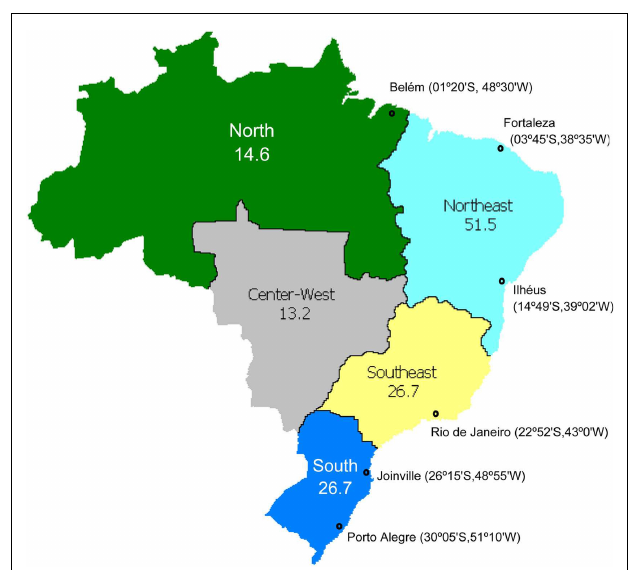
FIGURE 1 | Map of Brazil, showing its five geographical regions, their populations (in millions), and cities where individuals were recruited for the Refargen study, reviewed in this